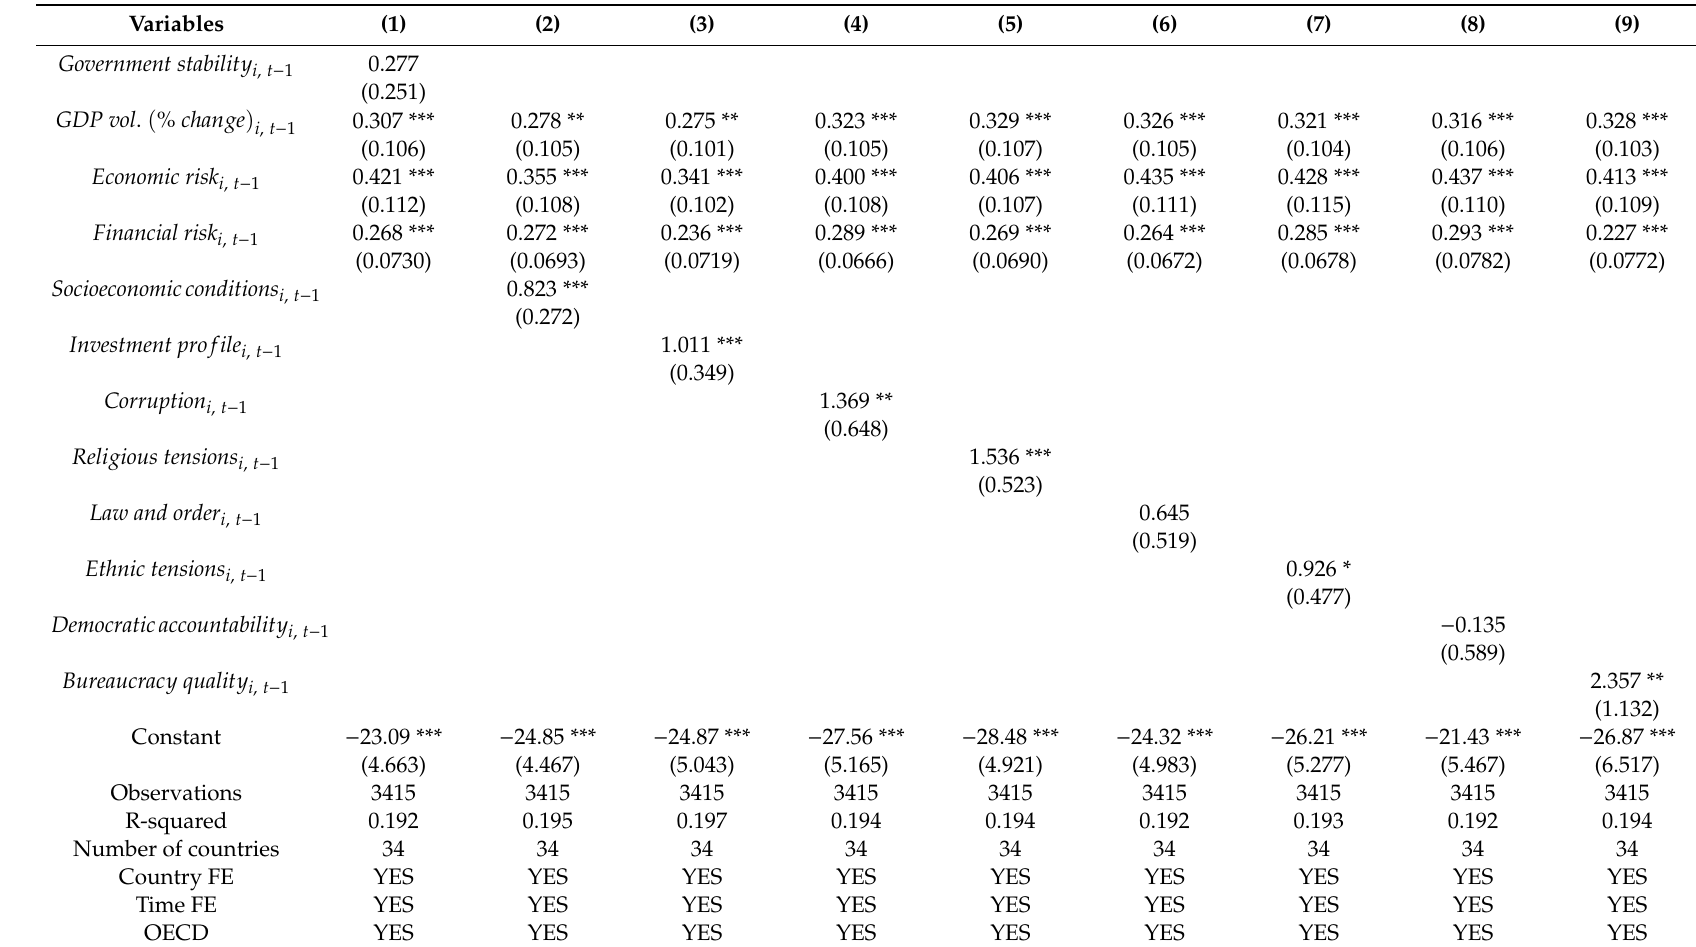
Table A6. Estimation results—components of political